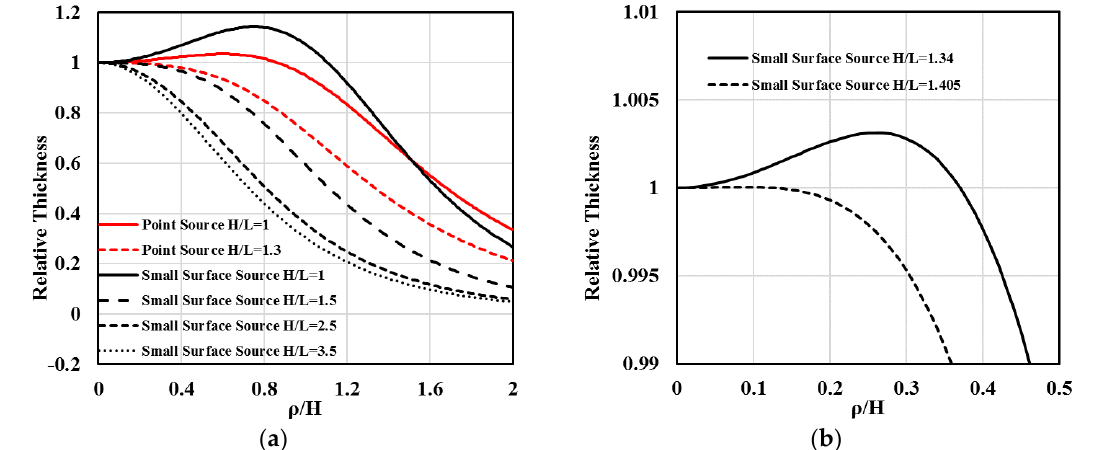
Figure 11. ( a ) Distribution of the thin film thickness on the rotating planar plate substrate holder; ( b ) Distribution for optimized H / L values, to demonstrate finer details for better comparison.